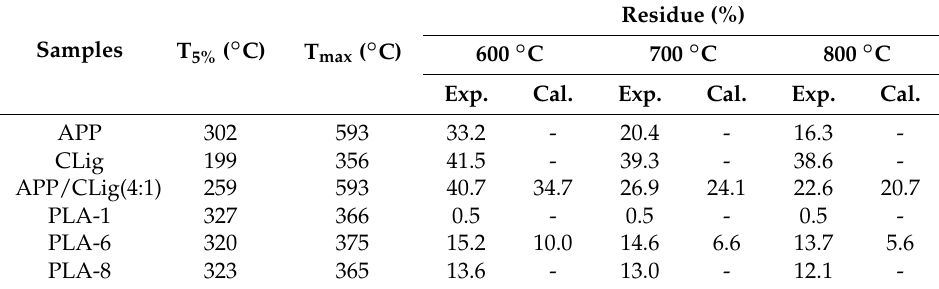
Figure 5. TG curves of PLA, APP/Clig, PLA/IFR composites and PLA-6(Calculation) under N 2 . Table 5. Thermal degradation parameters data of PLA and PLA composites under N 2.